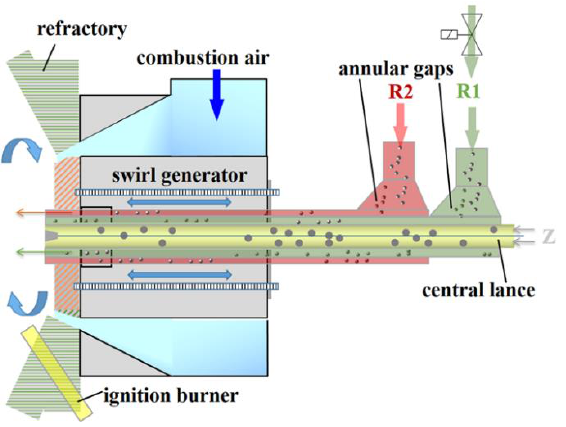
Figure 7. Schematic of the swirl-type burner.